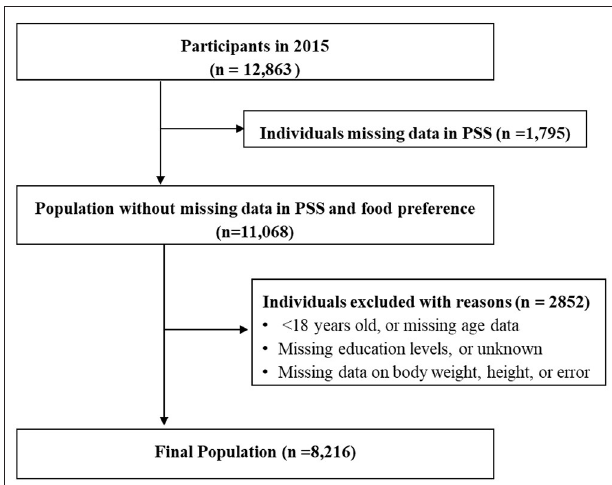
FIGURE 1 | Flow chart of the selection process of study participants from the China Health and Nutrition